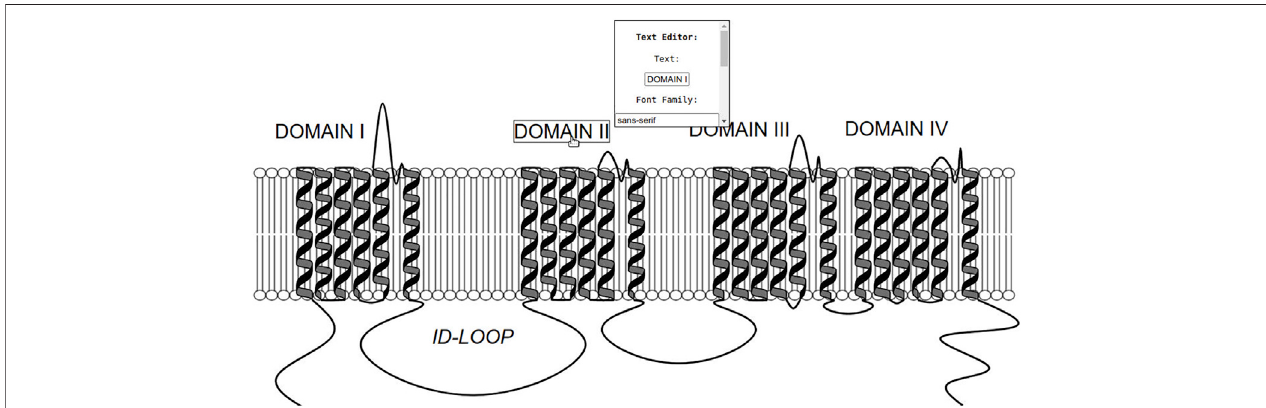
FIGURE 5 | Example of Naview ’ s text annotations. All domain-indicating texts were added by using the Naview Style Editor console in the text edition mode. Text position can be adjusted by clicking and dragging any added text element. A single click highlights the selected text annotation and allows the editing of its current text and font characteristics. In this example such annotations were used to indicate speci fi c domains (I-IV) and the fi rst intracellular loop (ID-LOOP). Helices are shown as black cartoons and the membrane as a lipid bilayer. All loop residues are scaled to two pixels.